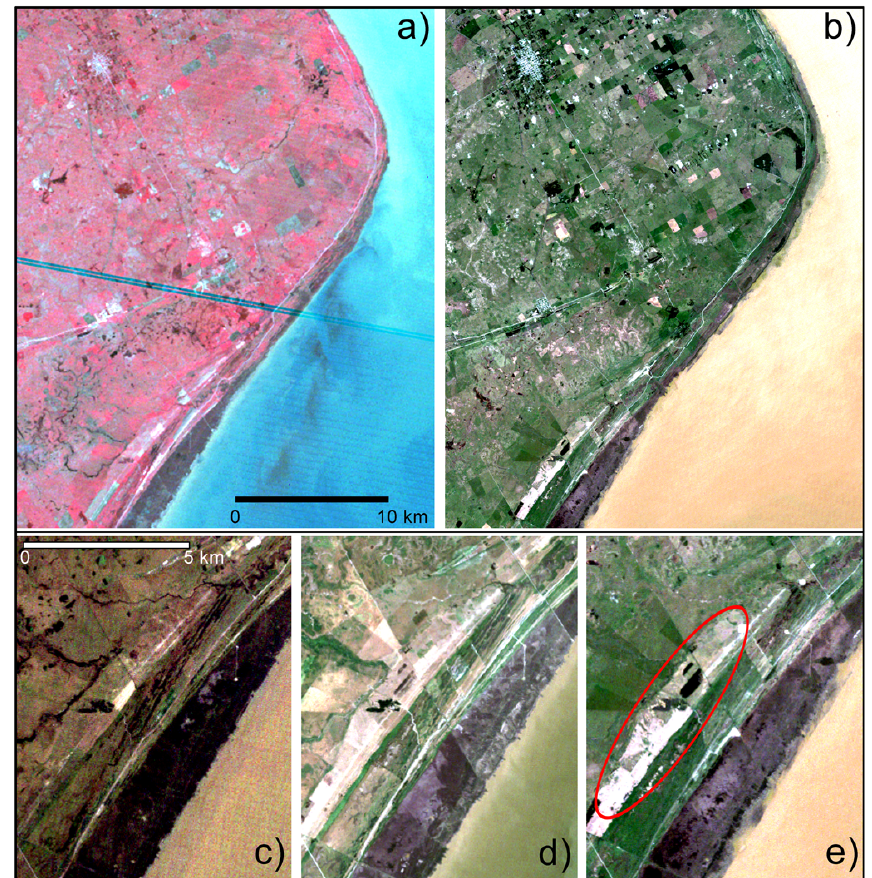
Fig. 2. Landsat images of the northern sector of the Samboromb´on coast acquired on (a) 20 September 1976 and (b) 1 October 2011. An example of the hydro-geomorphologic modifications caused by the quarrying of shell layers can be detected by comparing the details dated (c) 25 June 1987, (d) 30 November 1998, and (e) 1 October